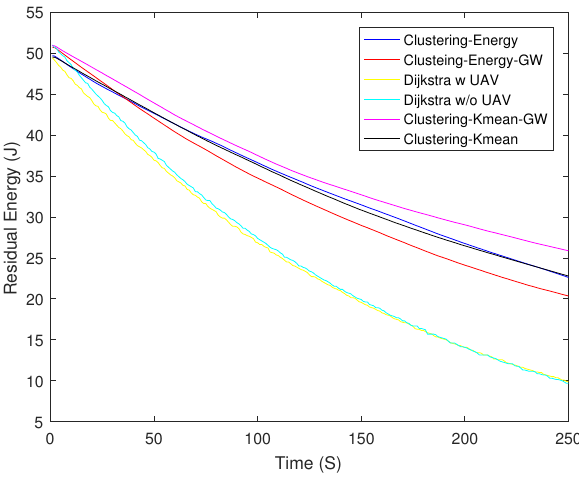
Figure 6. Residual energy.